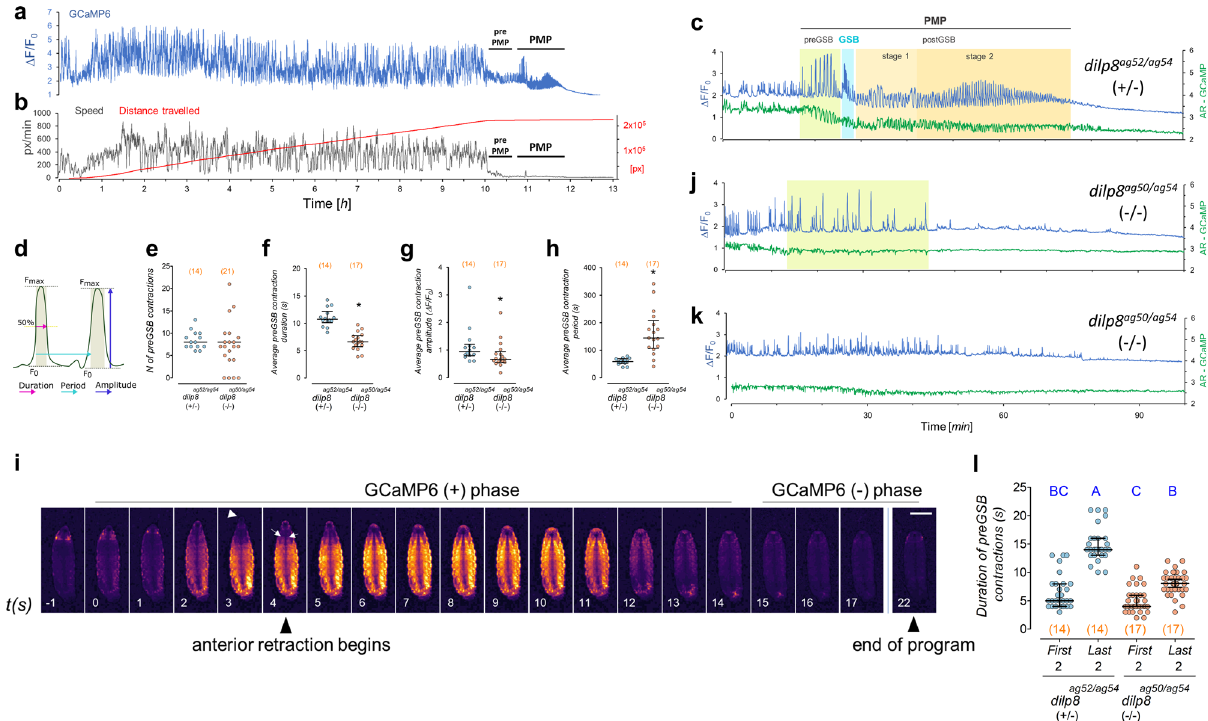
Fig. 4 Dilp8 is critical for progression of the pupariation motor program. a Muscle calcium (mhc»GCaMP) fl uctuations of a single WT ( dilp8 + / − ) larva (whole-body measurement, blue). Pupariation motor program (PMP). b Speed (black), and distance traveled by (red) the same larva depicted in a . c PMP in ( a ) and its speci fi c stages. Shown are mhc»GCaMP (blue) and aspect ratio (AR-GCaMP, green) fl uctuations. d Scheme describing the parameters measured for the pre-GSB contractions. e Dot plots showing the number of pre-GSB contractions of WT ( dilp8 + / − ) and dilp8 mutant ( dilp8 − / − ) animals. f – h Dot plots showing the average f duration, g amplitude, and h period of pre-GSB contractions in WT and dilp8 mutants. i Time-lapse of GCaMP oscillations during a WT pre-GSB contraction. Anteriormost segments are initially extruded (arrowhead) by the strong whole-body contraction and subsequently internalized by the activation of ventral longitudinal muscles (arrows). Representative pro fi le from 3 recorded animals. j An example of muscle calcium (mhc»GCaMP) fl uctuation (blue) and aspect ratio (AR-GCaMP, green) fl uctuations of a dilp8 mutant animal that showed pre-GSB-like contractions and one that k did not show any detectable pre-GSB contractions. l dilp8 mutants fail to increase the duration of the pre-GSB contractions with time. Shown are dot plots of the duration of the fi rst and last two pre-GSB contractions of WT and dilp8 mutants. Statistics (full details in Supplementary Table 2): e – h , l Dot: average per larva. Horizontal bar, median. Error bars: 25-75%. e , g , h Mann – Whitney Rank sum test. f Student ’ s t -test. l Dunn ’ s